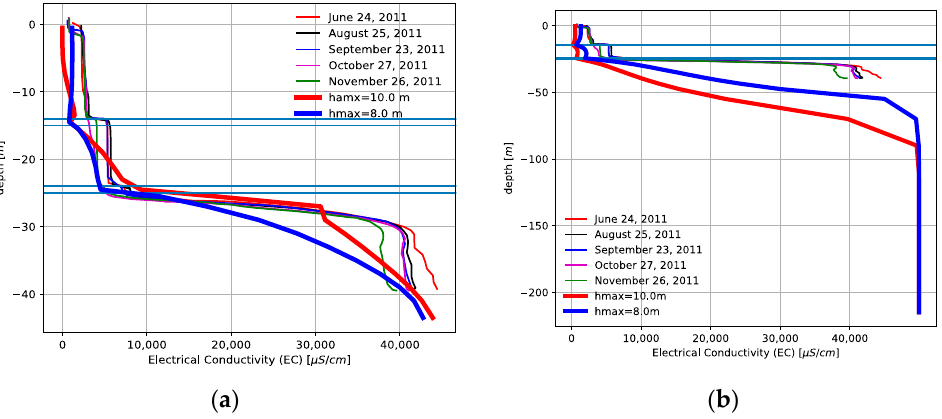
Figure 15. Comparison of the data of Figure 14 with the EC data in well 18 of Reference [21] using two different values of the constant head in the inland, for and aquifer of ( a ) − 45 m a.s.l.; ( b ) − 220 m a.s.l.